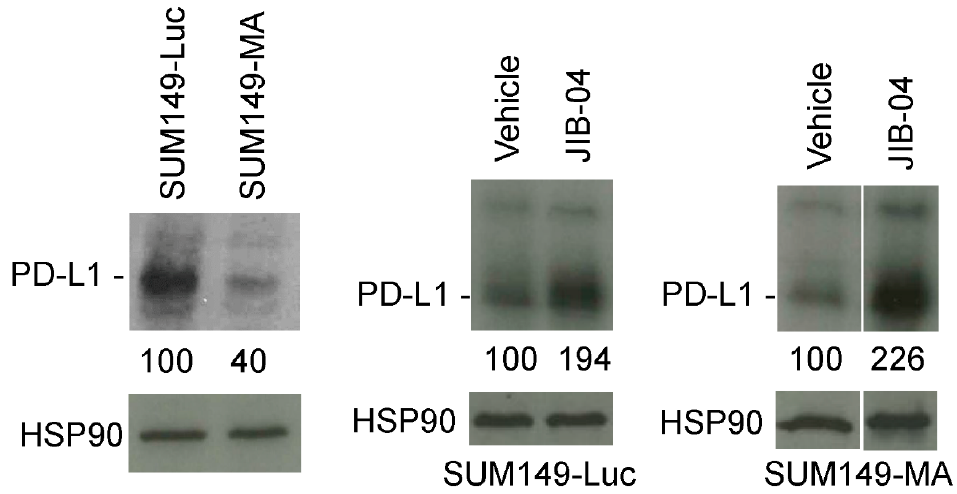
Figure 4. Increased PD-L1 protein levels in TN-IBC cells upon treatment with JIB-04. ( Left ) The PD-L1 protein level in SUM149-MA cells was lower than that in the parental SUM149-Luc cell line. The relative levels of PD-L1 protein in SUM149-MA and parental SUM149-Luc cells cultured in glutamine-containing medium with dialyzed FBS were determined via Western blotting. SUM149-Luc ( middle ) and SUM149-MA ( right ) cells were treated with 62.5 nM JIB-04 for 10 days, allowed to recover for 10 days in a drug-free medium, and subjected to Western blotting to compare the PD-L1 protein levels. Nitrocellulose membranes were re-probed with an anti-HSP90 antibody to normalize sample loading. The relative levels of PD-L1 protein, as quantitated by ImageJ analyses of band intensities, are shown below the PD-L1 blots. Cropped western blots are shown; see Figure S1 for uncropped blots.